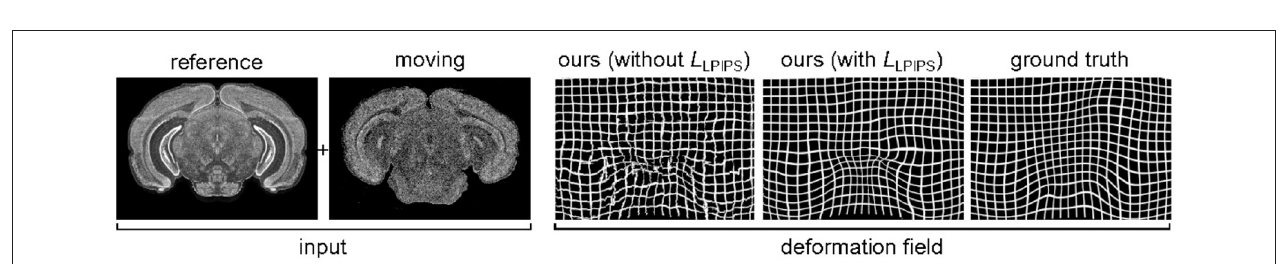
FIGURE 4 | Gene expressions containing artifacts, and corresponding predicted registrations. (A) PVALB gene, section 160; (B) VIP gene, section 316.